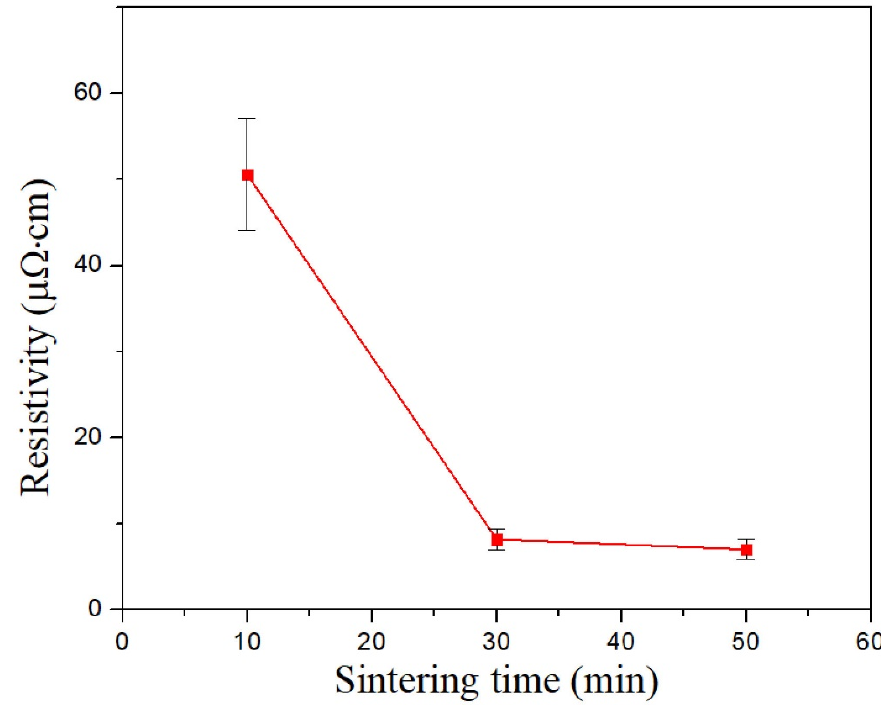
Figure 8. Electrical resistivities of the microvias filled with Cu@Ag NMPs at the sintering temperature of 220 °C and sintering time of 10 min, 30 min, and 50 min.